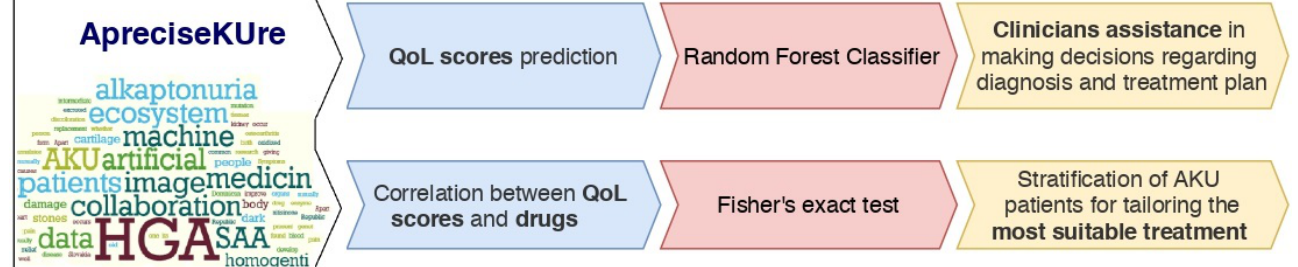
Figure 1. Workflow scheme represented by two stages, ’Quality of Life (QoL) scores prediction’ in the top and ’Correlation between QoL scores and drugs’ in the